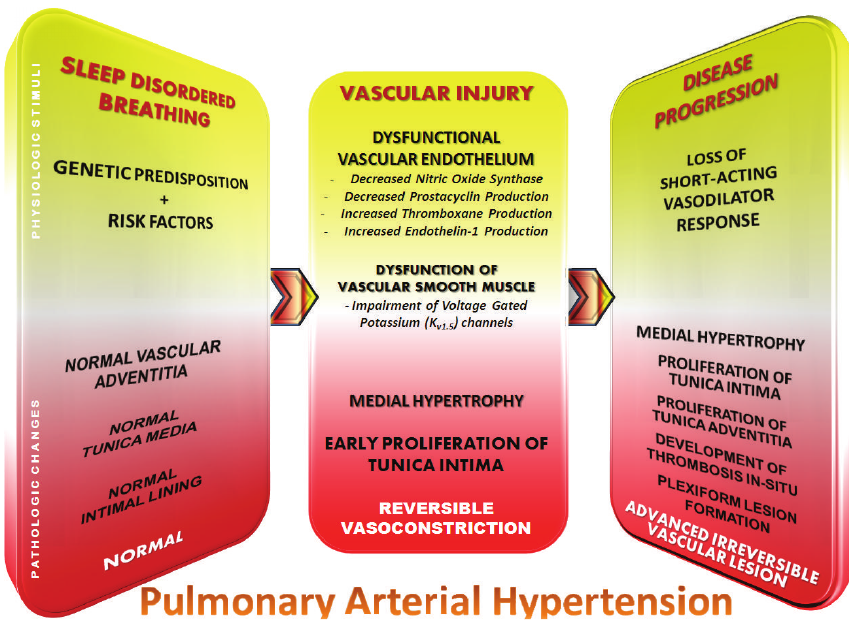
Figure 1: Pathogenesis of pulmonary hypertension [19,